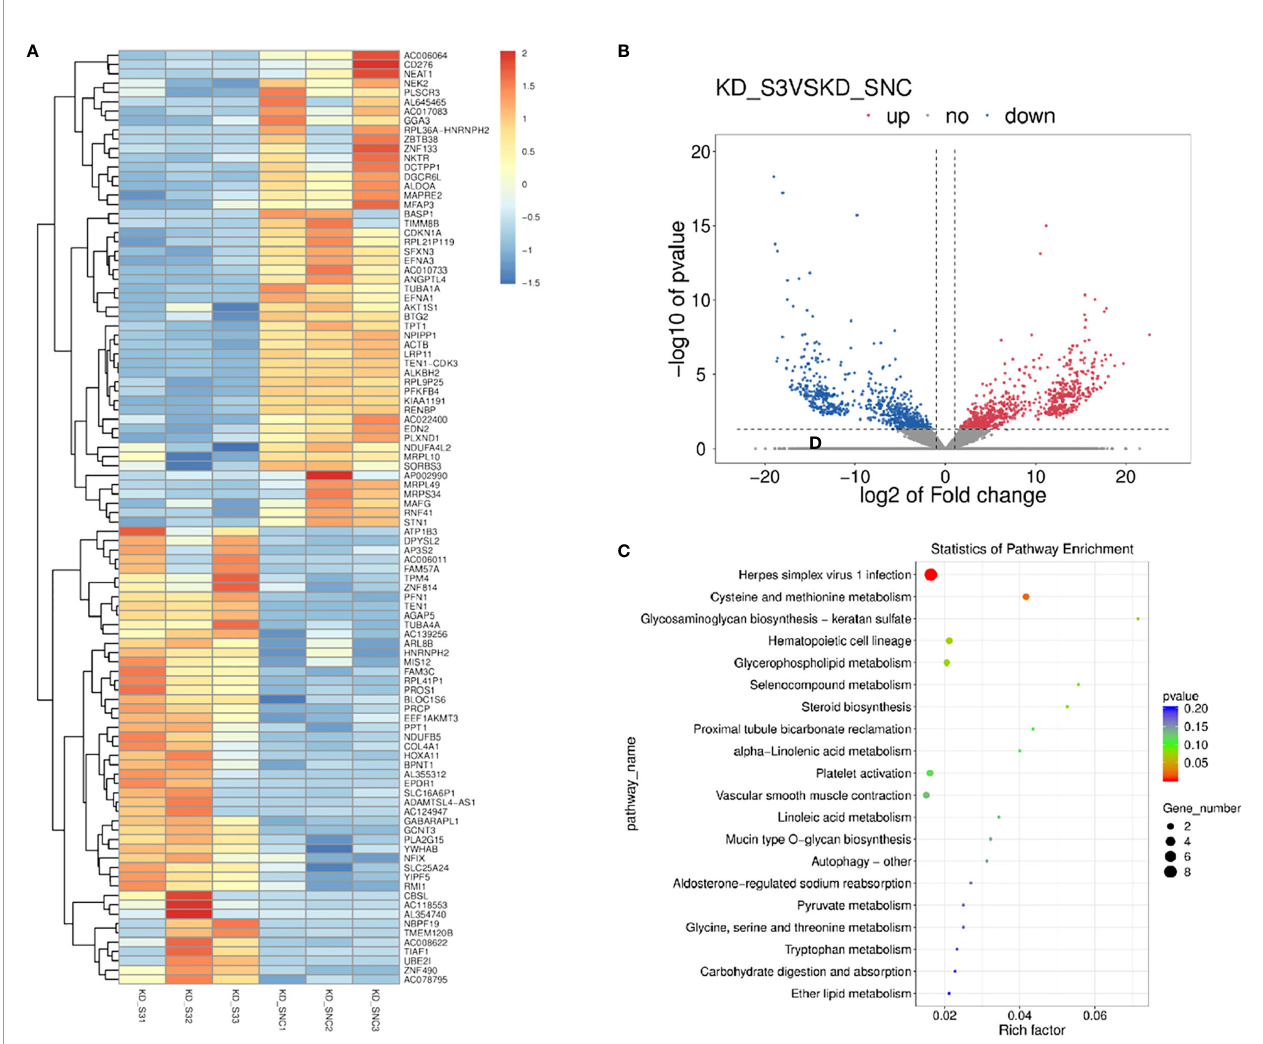
FIGURE 6 | The involvement of lncRNA AC007639.1 in different pathways. (A) Heatmap showing different gene expressions after the knock down of lncRNA AC007639.1 in HepG2 cells using siRNA3; (B) Volcano plot of different gene expressions after the knock down of lncRNA AC007639.1 in HepG2 cell line; (C) Pathways enrichment after the knock down of lncRNA AC007639.1 in HepG2 cell